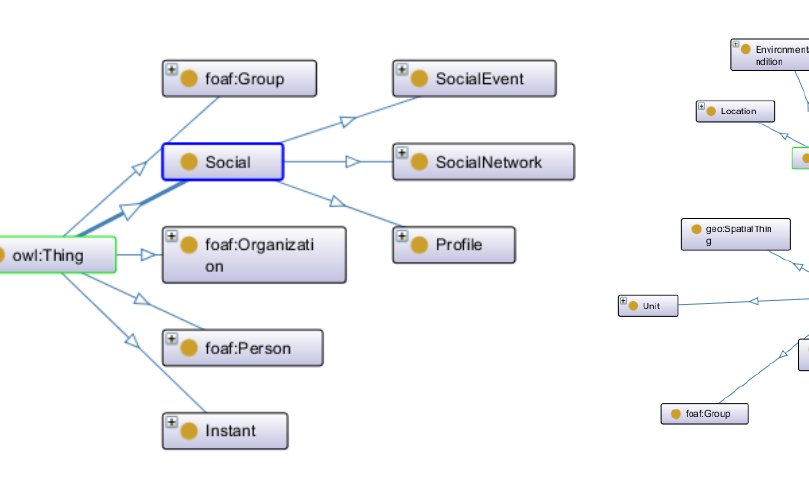
Figure 3. Social Context Ontology